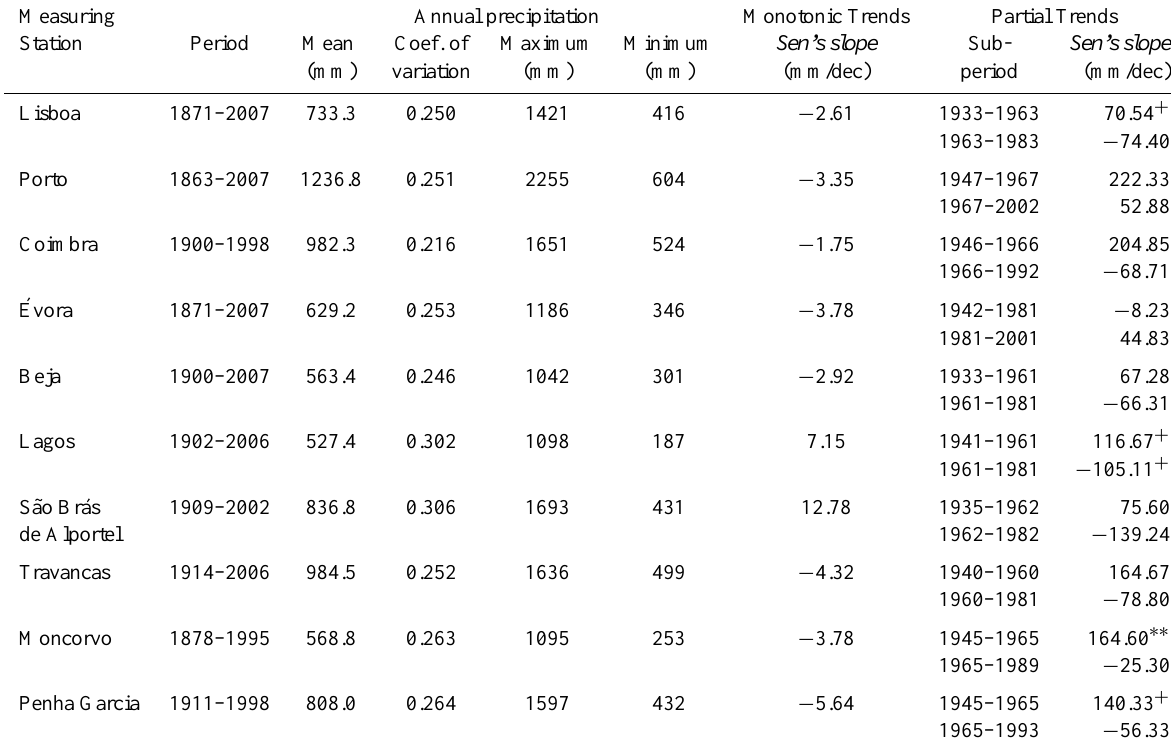
Table 1. Some descriptive statistics for the annual time series, and linear monotonic (full record period) and partial trends given by the Sen’s estimator of the slope (mm/decade). The confidence levels for the trend tests are marked: + 90% and ∗∗